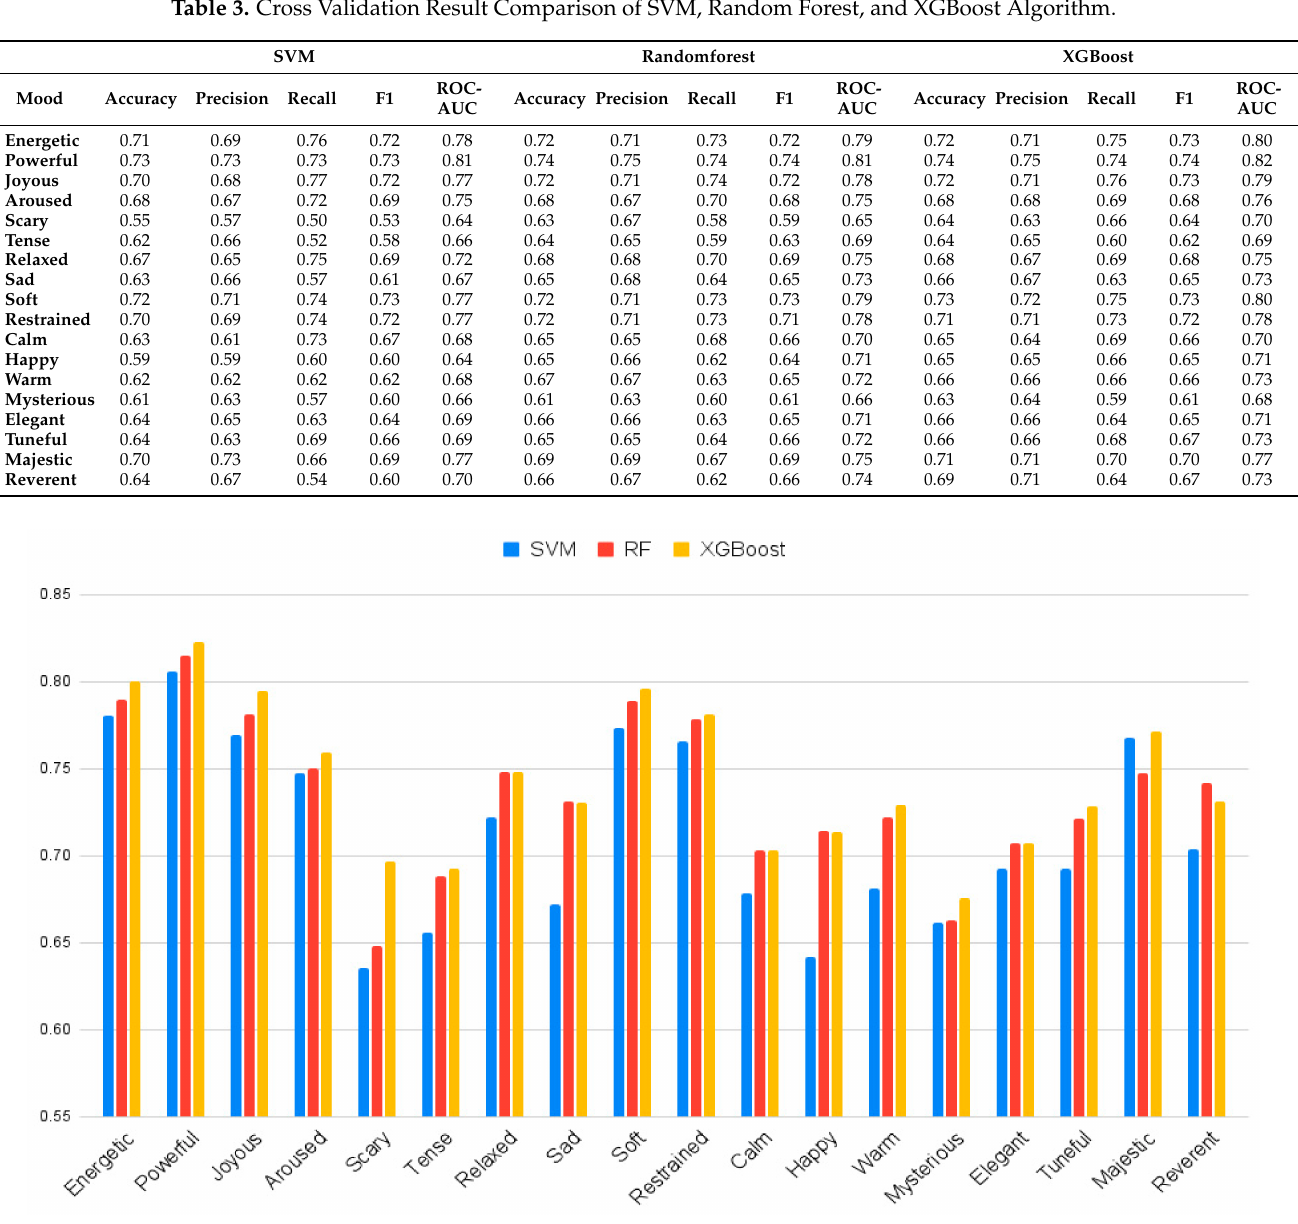
Figure 10. Comparison of ROC-AUC Performance Results Graph of Dataset B by SVM, Random Forest, and XGBoost